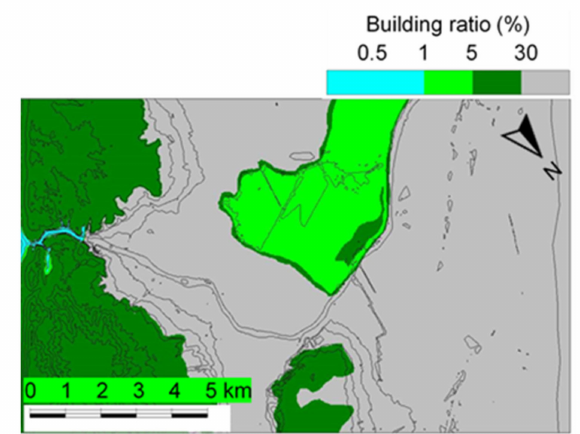
Figure 13. Building ratio in a calculation mesh (=the area ratio of buildings and trees in a